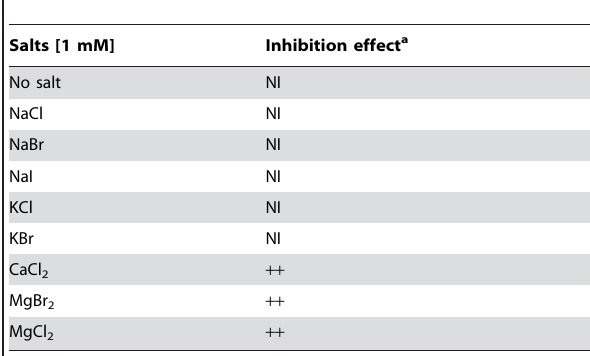
Table 4. Effects of various monovalent or divalent salt solutions (1 mM) on bactericidal activity of squalamine (2.5 m g/mL).